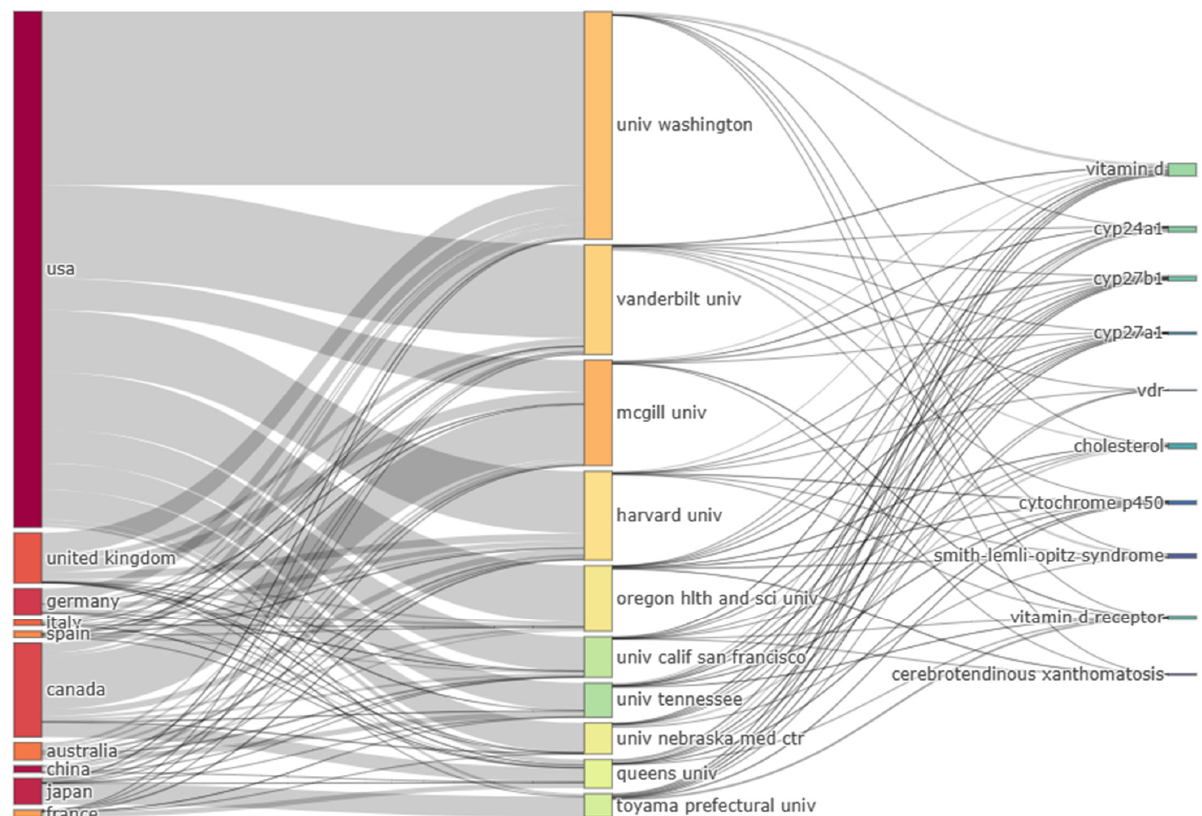
Figure 3. Three ‐ field plot ( N = 10 item/plot) of highly impacted countries ( left ), affiliations ( middle ), and keywords ( right ).